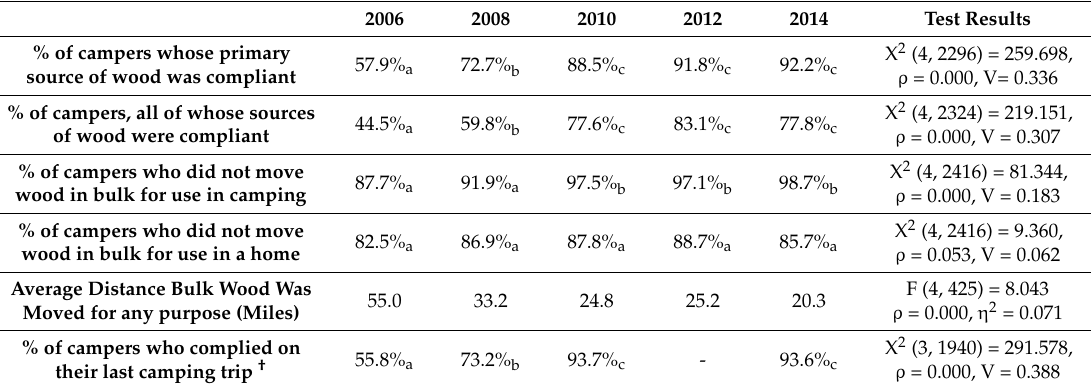
Table 4. Firewood movement rule compliance by campers ♦